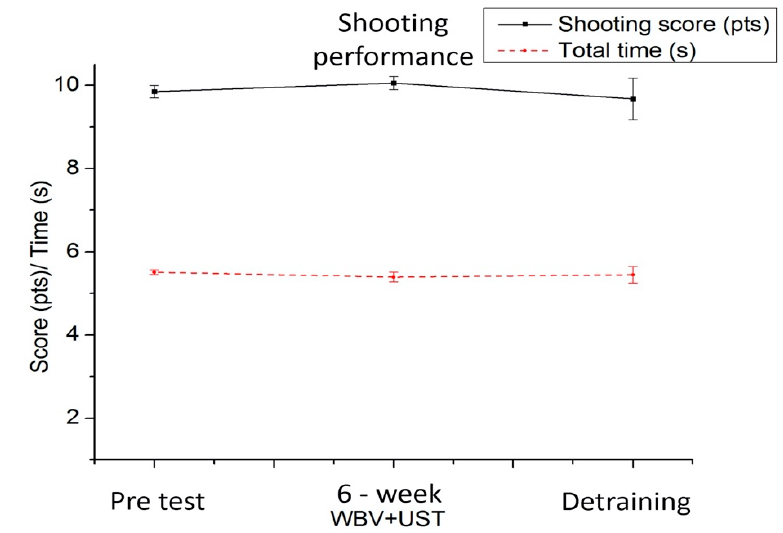
Figure 2. The difference phase during score and time of the shooting performance.